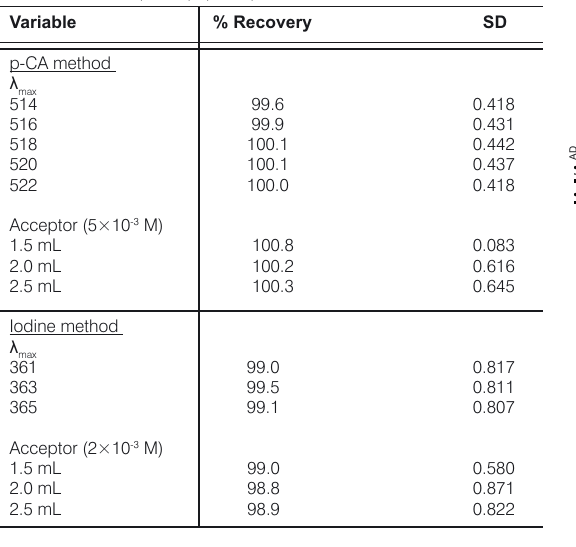
Table 3. Influence of small variations of operational conditions on the mean recovery of 2×10 -4 M SU (p-CA) and 2×10 -5 M SU (iodine), (n = 3).